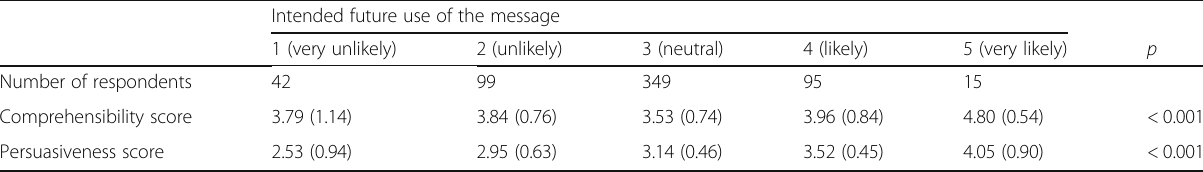
Table 4 Association between the overall scale score and intended future use of the message Intended future use of the